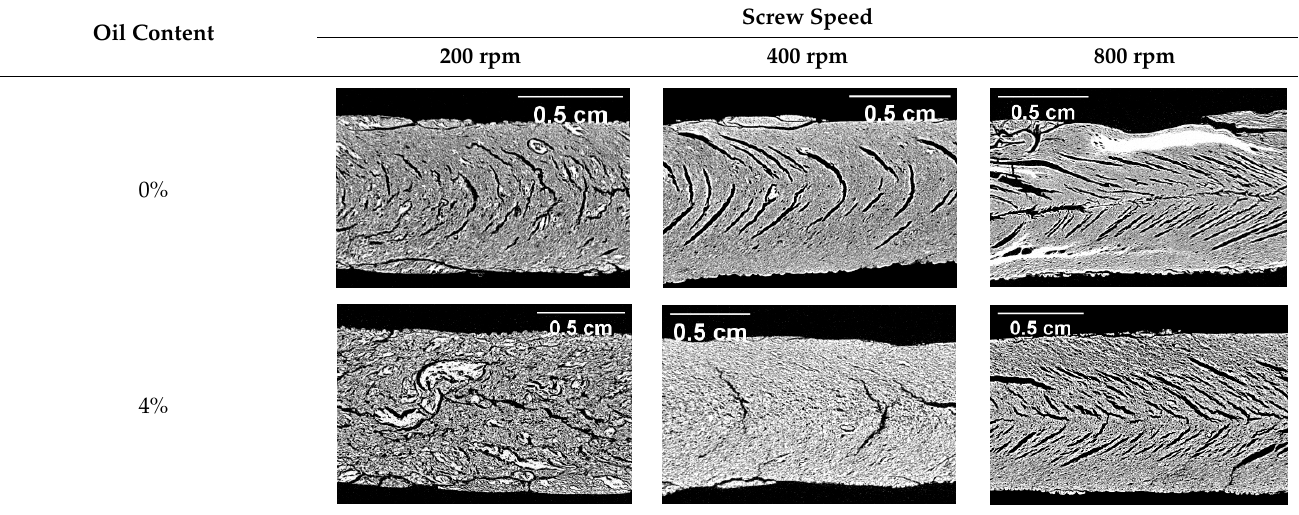
Table 4. Micro-CT images of freeze-dried extrudate samples. Effect of screw speed on the anisotropic structure of samples with 0 and 4% oil. Oil was added at position 2, barrel temperature was 140 °C, total mass flow was 10 kg/h and water content was 51–53% for all samples.